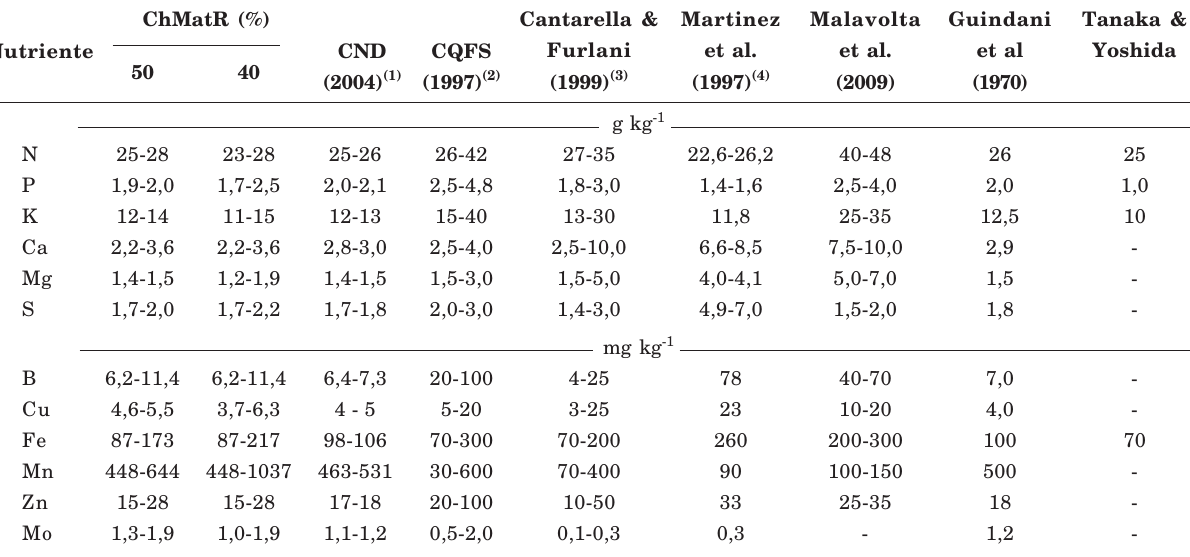
(1) Tipo de folha coletada: folha bandeira; época da coleta: R2 e R3; e número de folhas coletadas: 50 folhas. (2) Tipo de folha coletada: folha bandeira; época da coleta: início do florescimento (50 % de flores visíveis); e número de folhas coletadas: mínimo de 50 folhas. (3) Tipo de folha coletada: folhas recém-maduras; época da coleta: na maturidade; e número de folhas coletadas: 50. (4) Tipo de folha coletada: folha Y (posição ocupada em relação à folha mais nova desenrolada acima); época da coleta: meio do perfilhamento; e número de folhas coletadas: 50 folhas por